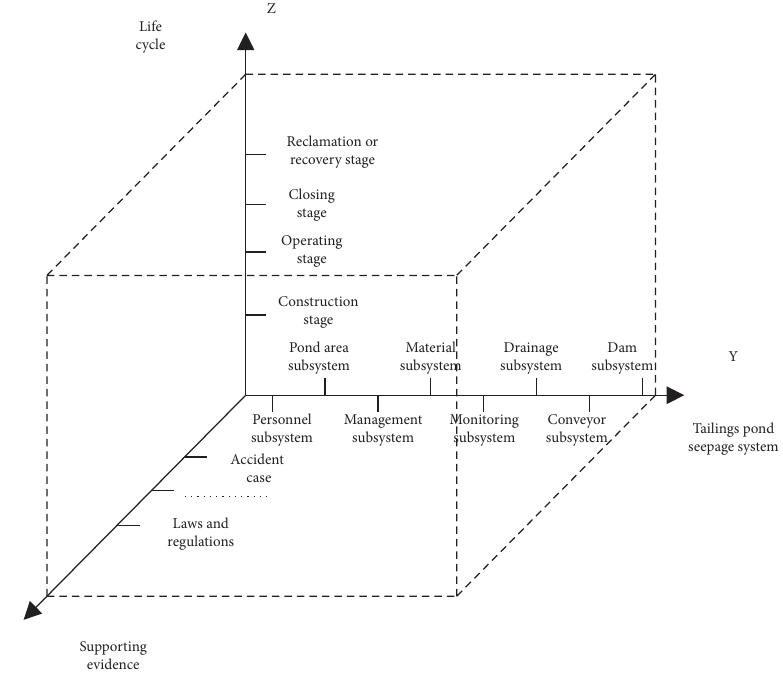
Figure 2: The evidence-based identification method of three-dimensional seepage